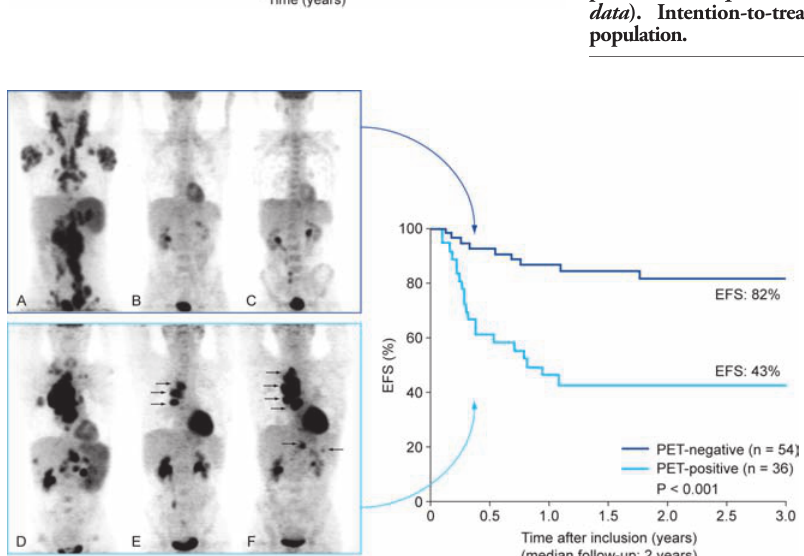
Figure 1. Progression-free survival (PFS) in 208 hard- to-treat patients (with an International Prognostic Index of 2-3) with diffuse large B-cell lymphoma, who were given four cycles of rituximab, doxorubicin, cyclo phosphamide, vinde- sine, bleomycin, and pred- nisone (R-ACVBP), fol- lowed by carmustine, etoposide, cytarabine, and melphalan (BEAM) and autologous stem-cell trans- plantation ( unpublished data ). Intention-to-treat